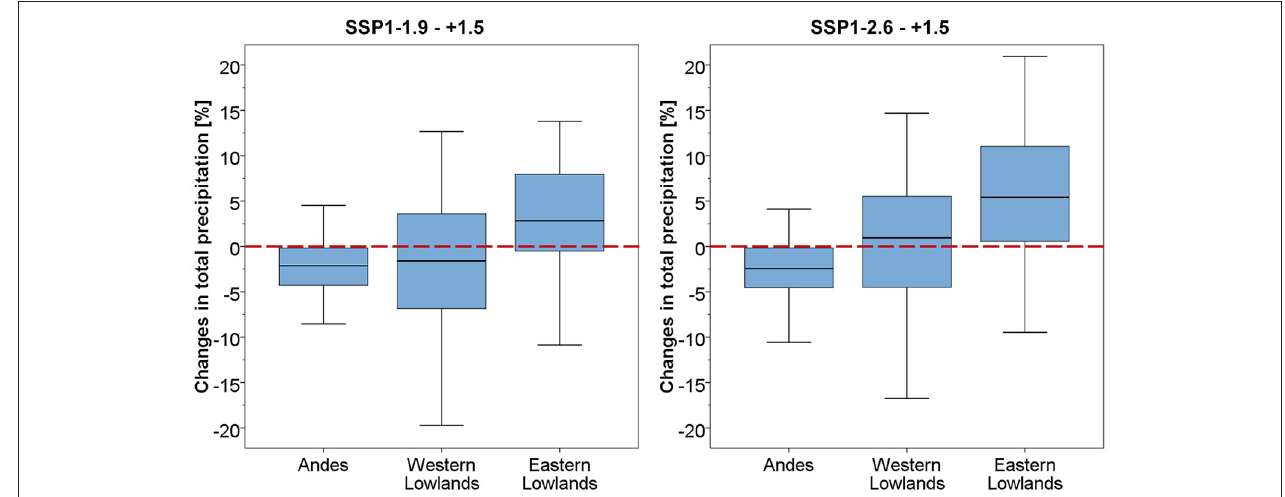
FIGURE 4 | Boxplot of the projected changes in annual precipitation (pr) for the warming level of 1.5 ◦ C, expressed as the percentage of change relative to the 1981–2010 baseline period, over the Andes and Lowlands domains. The Lowlands region was divided into its Eastern and Western parts for a more detailed description of the expected changes in precipitation. The left (right) panel shows the projected changes considering the SSP1-1.9 (SSP1-2.6) scenario when the temperature anomaly reaches 1.5 ◦ C above preindustrial levels. Each boxplot shows the median and first and third quartiles, while the whiskers extend to the data values that are 1.5 times the interquartile range above or below the